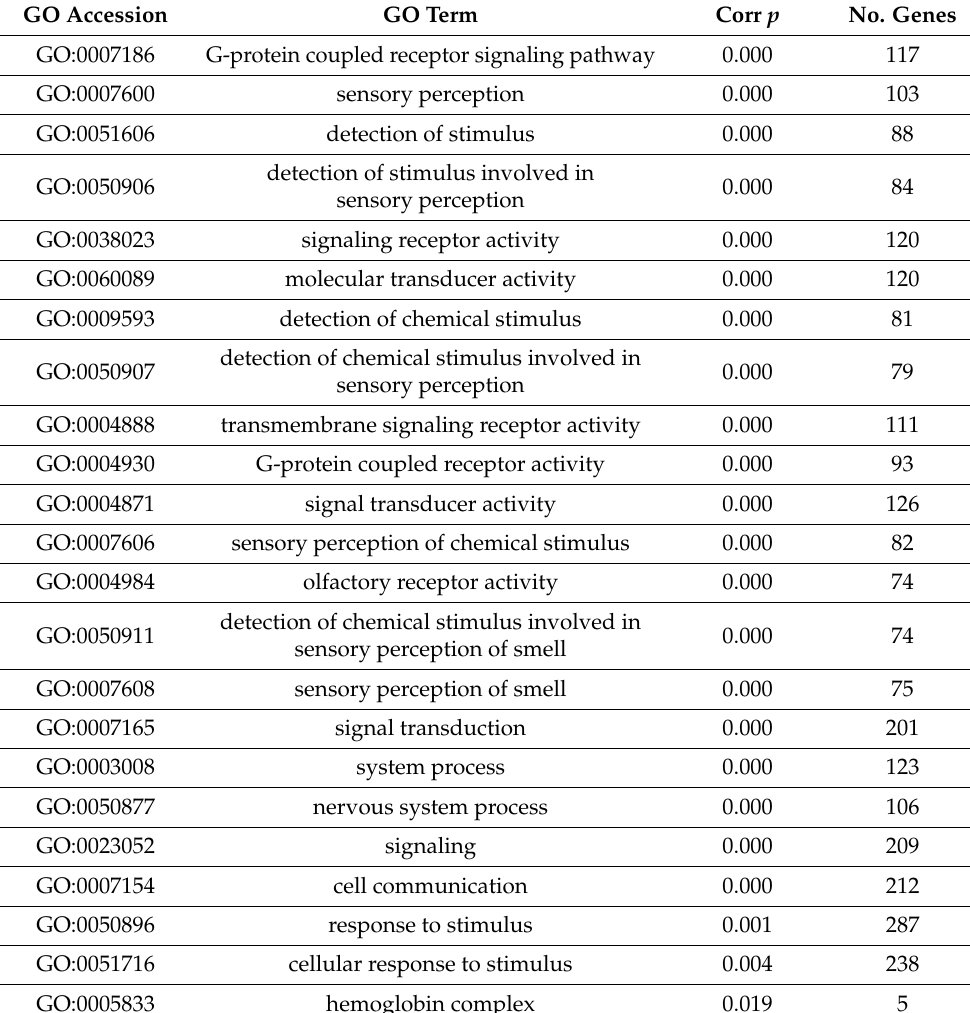
Table 1. Gene Ontology (GO) terms enriched from significantly downregulated genes between rats with manic-like behavior and control rats in the